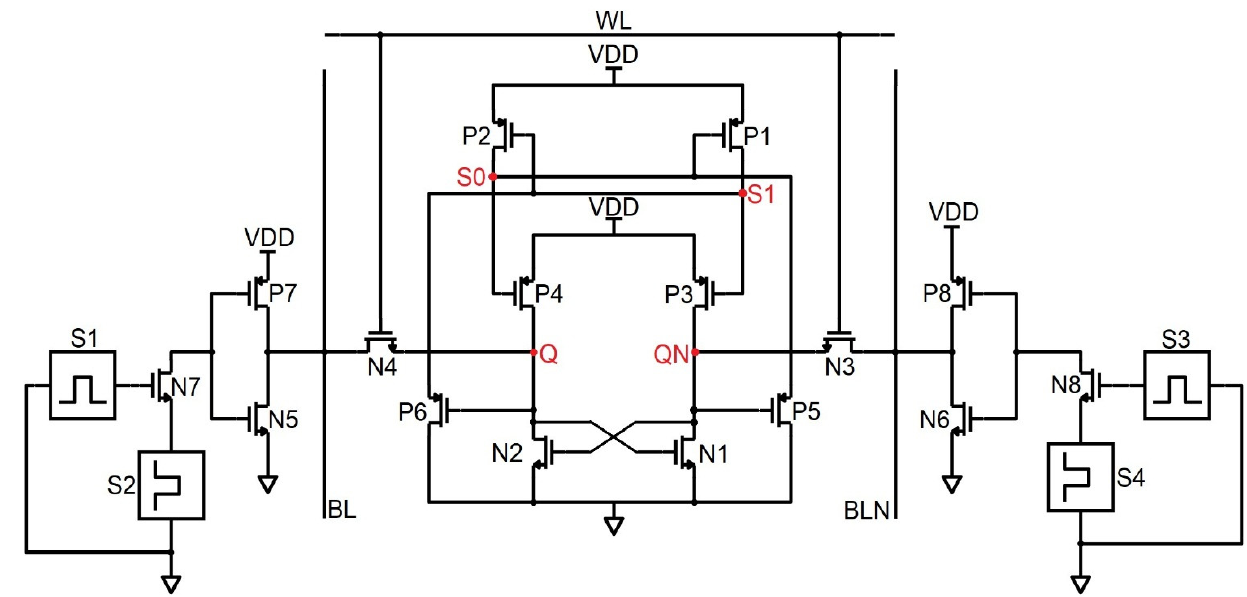
Figure 10. Schematic diagram of the 10T bit cell with a driver circuit.